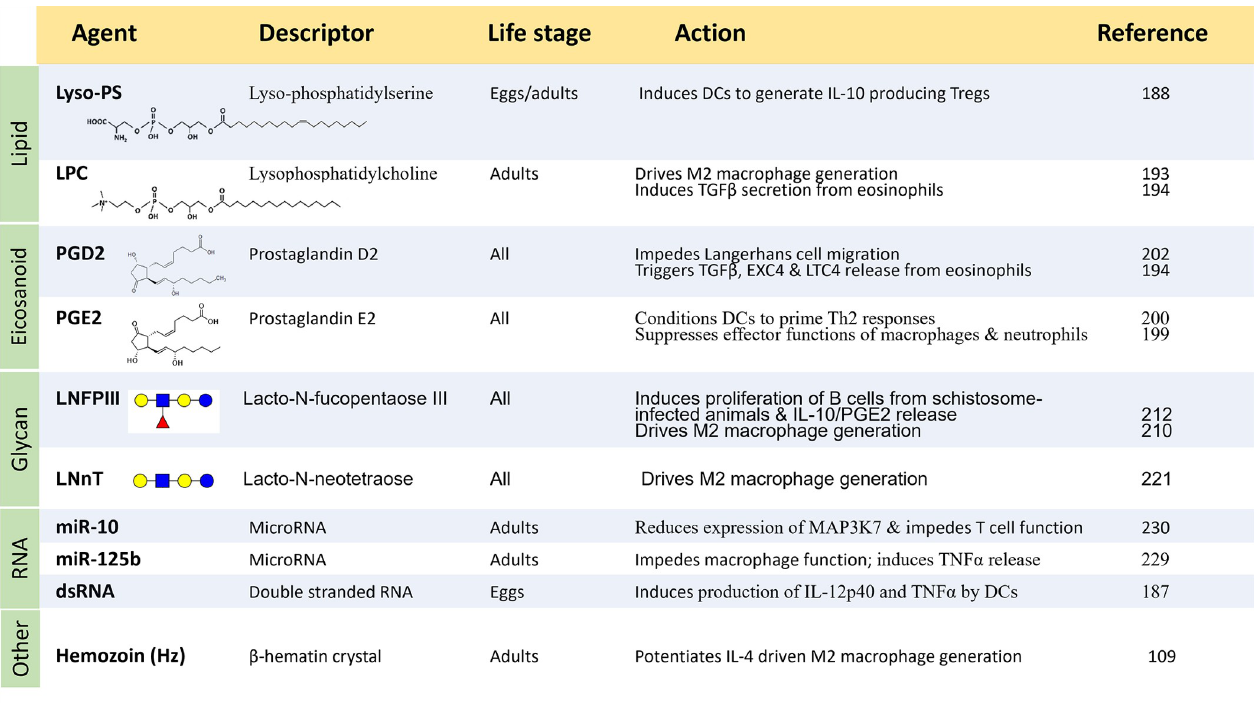
Fig 5. List of nonprotein immunomodulatory schistosome products and their major effects. Structural representations of some molecules are presented: For the glycans LNFPIII and LNnT, blue circles depict glucose, blue squares N-acetylglucosamine, yellow circles galactose, and the red triangle indicates fucose. Lyso-PS 20:1 and LPC 16:0 are depicted. DC, dendritic cell; EXC4, eoxin C4; LTC4, leukotriene C4; TGF- β , transforming growth factor beta; TNF α , tumor necrosis factor alpha; Treg, regulatory T